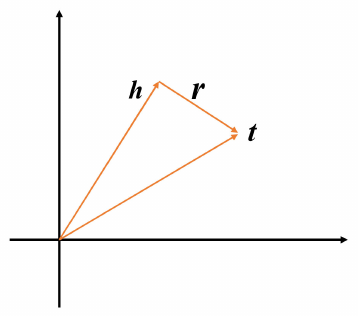
Figure 3. TransE model illustration. h representing head entity, r representing relation, t represent‑ ing tail